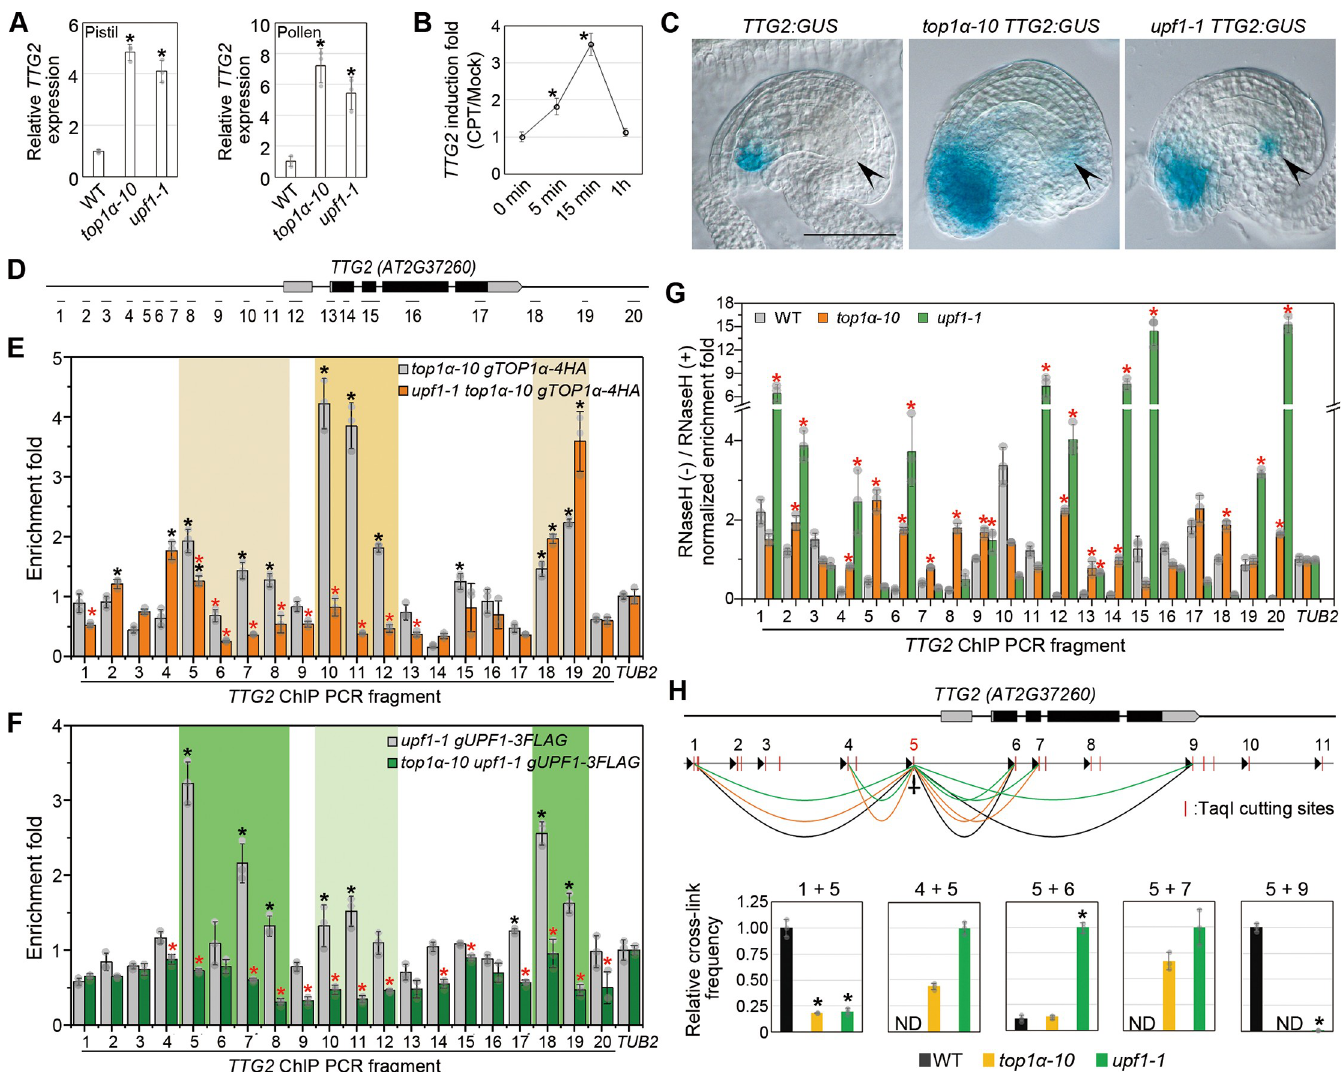
Fig 4. TOP1 α and UPF1 directly repress TTG2 . (A) TTG2 expression in pistils (left panel) or pollens (right panel) in different genetic backgrounds. Expression values normalized against U-BOX are shown relative to the expression level in WT. Values are mean ± s.d. of three biological replicates. � P < 0.05 as compared to WT, two- tailed Student’s t test. (B) CPT treatment induces TTG2 expression. Time-course experiments were conducted by treating the pistils with 10 μ M CPT or mock solution. Fold change of CPT-treated versus mock-treated at each time point is presented as mean ± s.d. of three biological replicates. � P < 0.05 as compared to “0 min,” two- tailed Student’s t test. (C) Representative GUS staining of TTG2 : GUS in WT (left), top1 α -10 (middle), and upf1-1 (right) backgrounds. Scale bar, 50 μ m. Arrowheads indicate antipodal cells. (D) Schematic diagram of the fragments amplified in ChIP and DRIP analysis spanning the TTG2 genomic region. The coding and untranslated regions are indicated by black and gray boxes, respectively, and introns and other genomic regions are indicated by black lines. (E, F) ChIP analysis of TOP1 α -4HA (E) and UPF1-3FLAG (F) binding to the TTG2 genomic region. Pistil samples were harvested for ChIP analysis using anti-HA (E) or anti-FLAG (F). Values are mean ± s.d. of three biological replicates. The black asterisks indicate significant enrichment compared to that of TUB2 . The red asterisks indicate significantly decreased enrichment when UPF1 is absent (E) or TOP α is absent (F). � P < 0.05, two-tailed Student’s t test. (G) DRIP analysis at TTG2 genomic region. Pistil samples were harvested for DRIP analysis using S9.6 antibody. Values are mean ± s.d. of three biological replicates. The red asterisks indicate significantly higher enrichment in comparison with WT. � P < 0.05, two-tailed Student’s t test. (H) 3C analysis of chromatin looping at the TTG2 locus. Upper panel: Schematic diagram of the spatial interactions at TTG2 genomic locus. Detectable spatial interactions are linked by black (in WT), orange (in top1 α -10 ), and green arcs (in upf1-1 ) between the anchor point (site 5) and surrounding loci. Arrowheads indicate the primers for qPCR. Lower panel: the cross-link frequencies are shown relative to the strongest interaction at each site. Values are mean ± s.d. of three biological replicates. � P < 0.05 as compared to WT, two-tailed Student’s t test. The data underlying this figure are included in S1 Data. 3C, chromatin conformation capture; ChIP, chromatin immunoprecipitation; CPT, camptothecin; DRIP, DNA:RNA hybrid immunoprecipitation; GUS, β